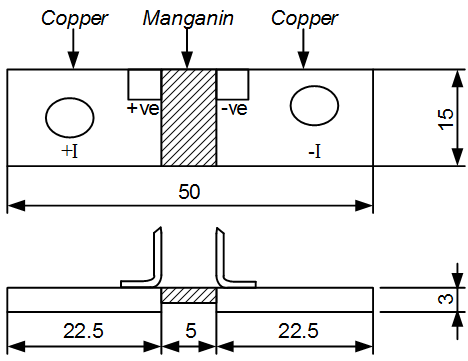
Figure 1. Manganin Alloy Shunt Construction (dimensions in mm).